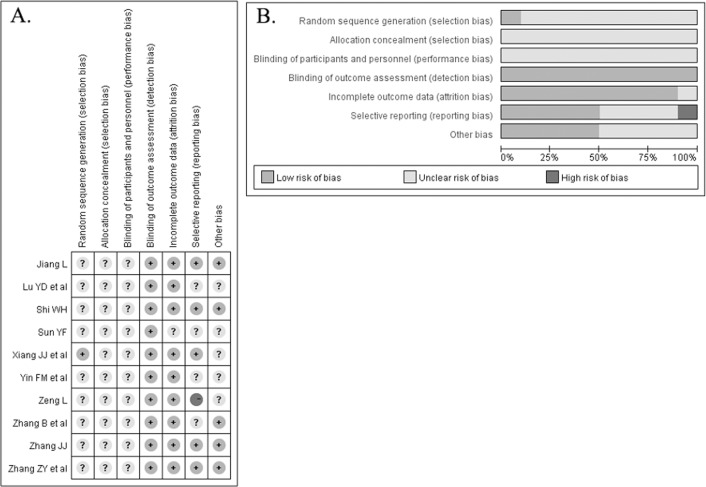
Risk of bias summary (A) and risk of bias graph (B)